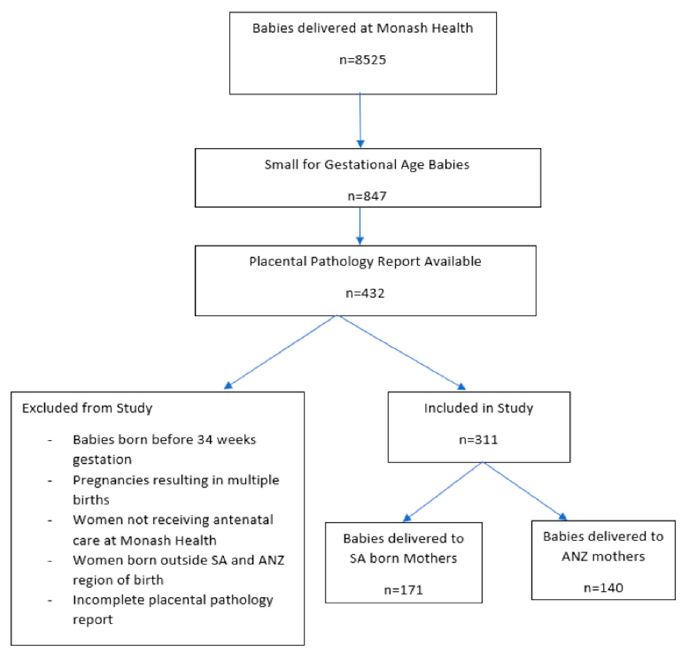
Figure 1. Flow diagram of included neonates.